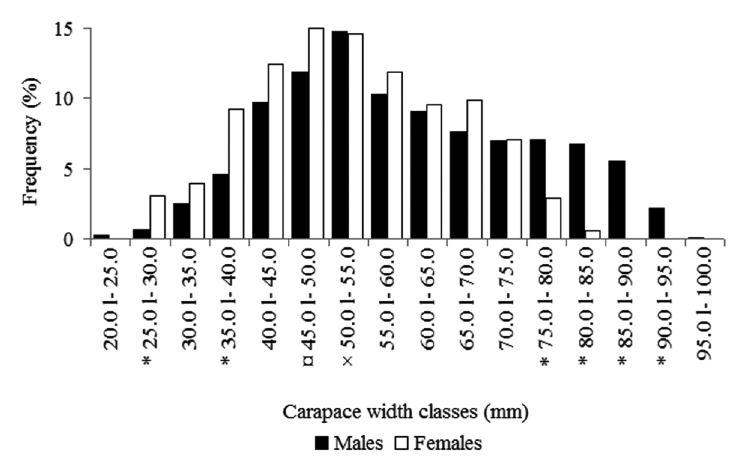
Fig. 4 – Callinectes danae . Frequency distribution of males and females into CW size classes at the Santa Cruz Channel. = significant differences (α = 0.05); ¤ = mode of females; × = mode of males.